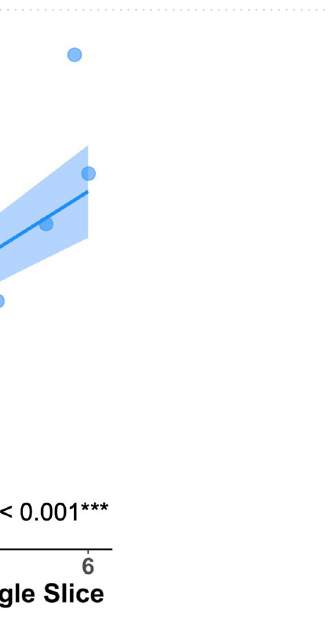
Figure 1. PVSs identified on a single astronaut. Here we depict a binary mask of PVSs for a single astronaut at the last pre-flight time point (Launch-60 days), for illustrative purposes. PVSs are shown in red, overlaid onto this individual’s native space 3D-rendered white matter segment (left) as well as several sagittal slices of their skull stripped native space structural scan (right). The blue box shows a zoomed-in view of one PVS, inside the blue circle.